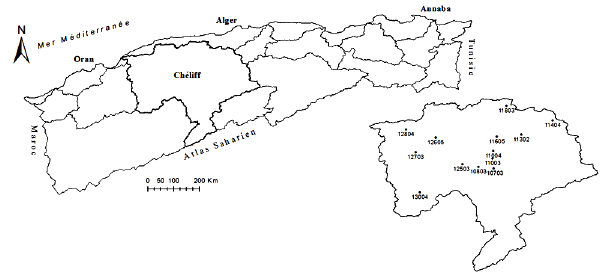
Figure 1. Limites des bassins versant du Nord de l’Algérie et loca- lisation des stations du Chéliff.